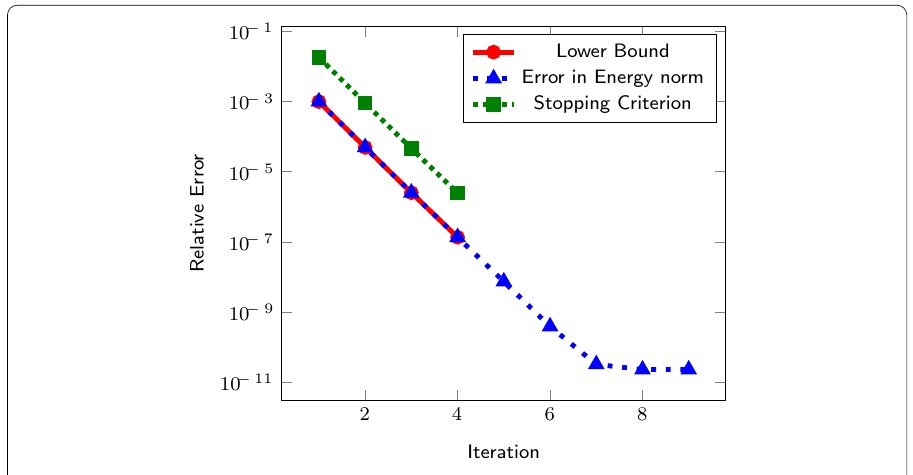
Fig. 8 Convergence of GKB method for Problem 3 for prestressed block example, ( m = 23043, n = 11382).